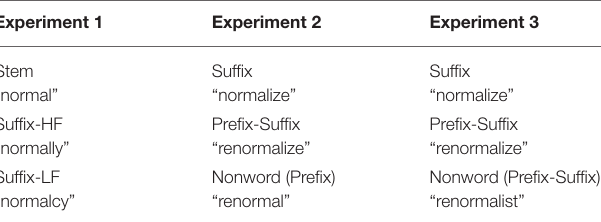
TABLE 1 | Overview of the experimental conditions in the three experiments, with example stimuli derived from the stem